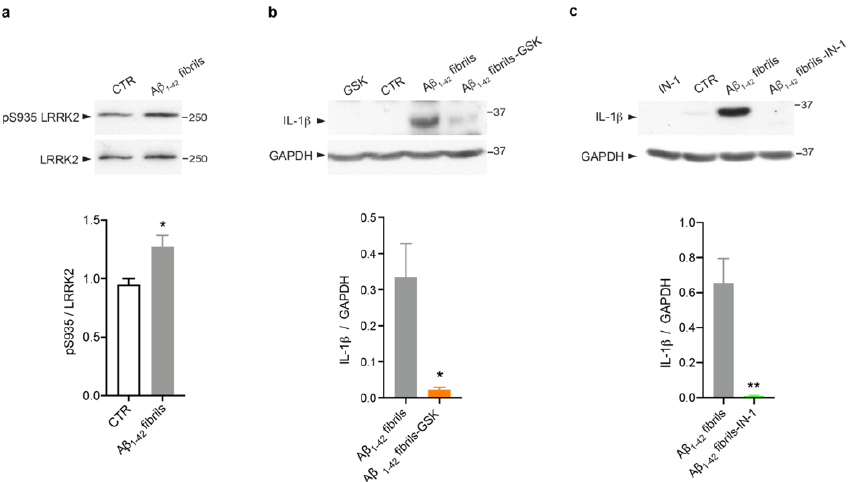
Figure 3. LRRK2 kinase activity controls A β 1-42 fibril-mediated astrocytic inflammation. ( a ) Cell lysates of primary astrocytes treated for 16 h with A β 1-42 fibrils, or with DMSO-HCl 10 mM- as control, were subjected to immunoblotting using LRRK2-phosphoserine 935 (pS935) and LRRK2 antibodies. Data are representative of three independent experiments and are expressed as the mean ± SEM. Data were analyzed using unpaired t -test, * p = 0.0423. ( b ) Cell lysates of primary astrocytes treated with A β 1-42 fibrils, A β 1-42 fibrils and GSK, GSK alone or DMSO as control were subjected to immunoblotting using IL-1 β and GAPDH antibodies. Data are representative of three independent experiments and are expressed as the mean ± SEM. Data were analyzed using unpaired t -test, * p = 0.0282. ( c ) Cell lysates of primary astrocytes treated for 16 h with A β 1-42 fibrils, A β 1-42 fibrils and IN-1, IN-1 alone or DMSO as control were subjected to immunoblotting using IL-1 β and GAPDH antibodies. Data are representative of three independent experiments and are expressed as the mean ± SEM. Data were analyzed using unpaired t -test, ** p =